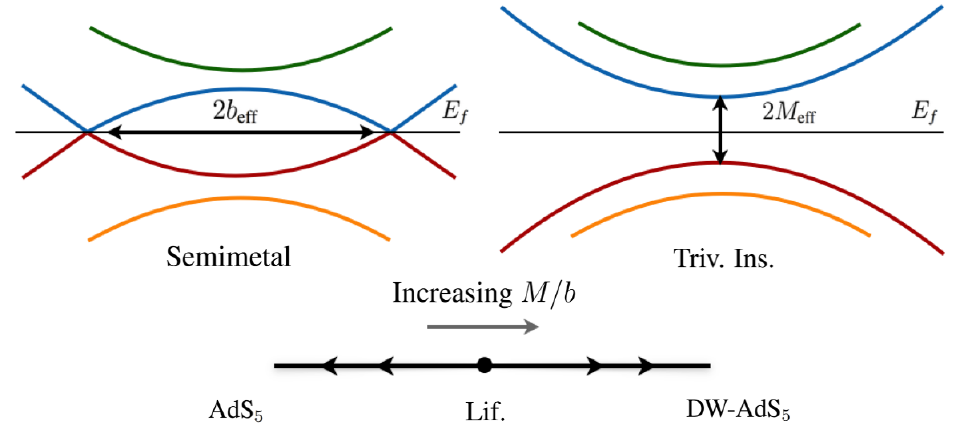
Figure 2. There is a topologically non-trivial to trivial phase transition as M=b increases (from left to right). Due to broken time-reversal symmetry, the 2-fold degeneracy has been lifted, giving rise to 4-bands in eq. (2.1). The (top) left (cid:12)gure has two Weyl nodes (a pair of Dirac cones where the bands cross) separated by 2 ~b e(cid:11) in momentum. The band structure on the (top) right is that of a topologically trivial insulator with an explicit band-gap 2 M e(cid:11) . At the QCP, the two Dirac cones merge together, giving rise to a Lifshitz (cid:12)xed point (black dot in the bottom (cid:12)gure) with a scaling anisotropy along the same direction as ~b . In the holographic picture, away from the QCP, the theory (cid:13)ows to two di(cid:11)erent types of (deep IR) near-horizon geometries, AdS 5 (Weyl semimetal phase) or domain wall-AdS 5 (trivial insulator phase). The (cid:12)gure shares some resemblances with those in [7,